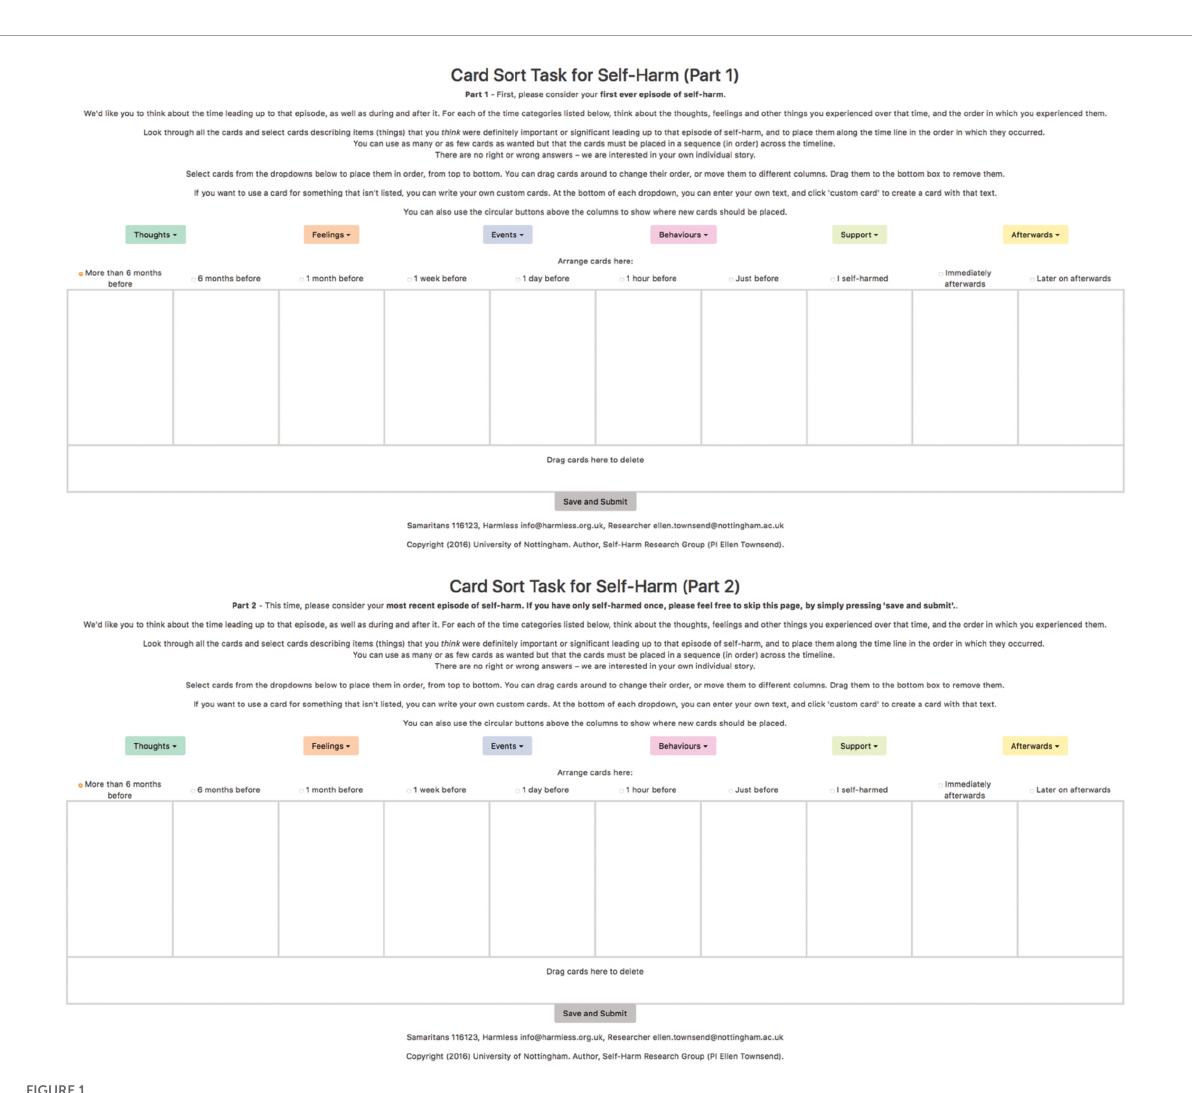
FIGURE1 A screenshot of the first ever and most recent episode of self-harm tasks for